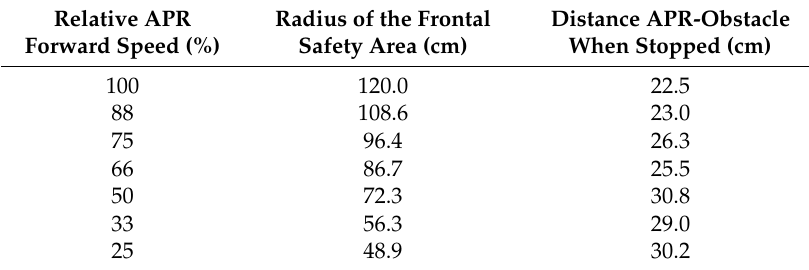
Table 8. Collision avoidance test